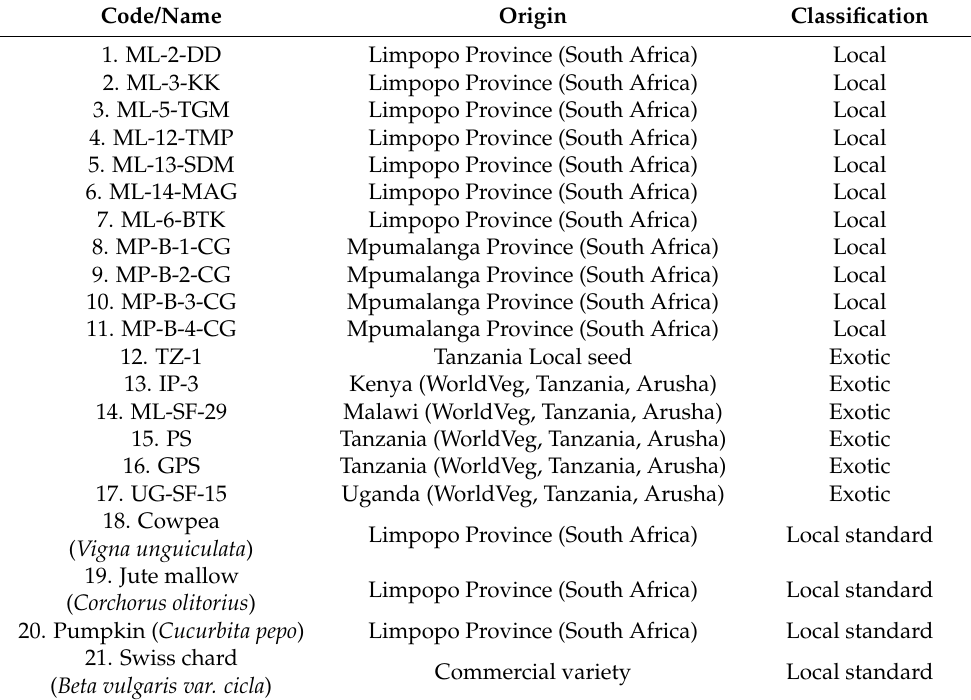
Table 9. Origins of the spider plant genotypes and other leafy vegetables that were used in this study. Code/Name